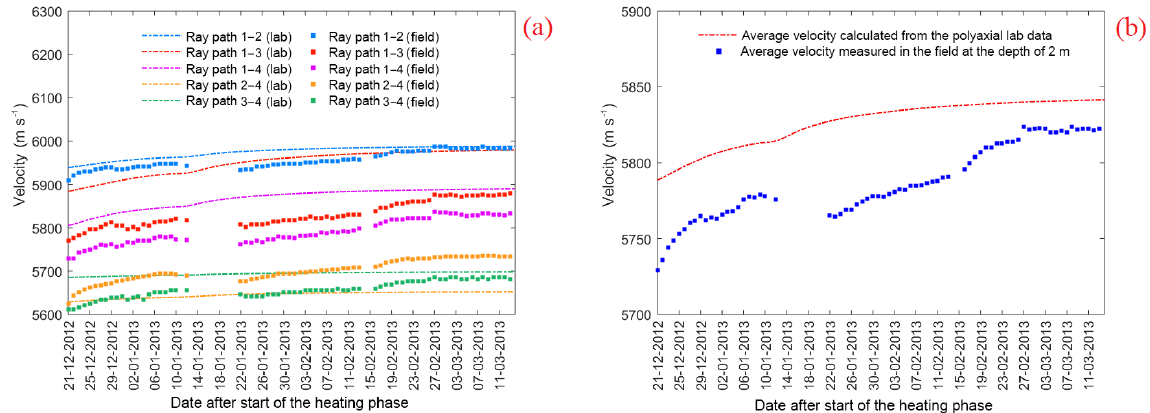
Figure 12. A comparison of the field and laboratory P-wave velocities; (a) Along the individual ray paths; (b) averaged over all the ray path at a depth of 2m (after Nasseri Behrestaghi et al., 2018).